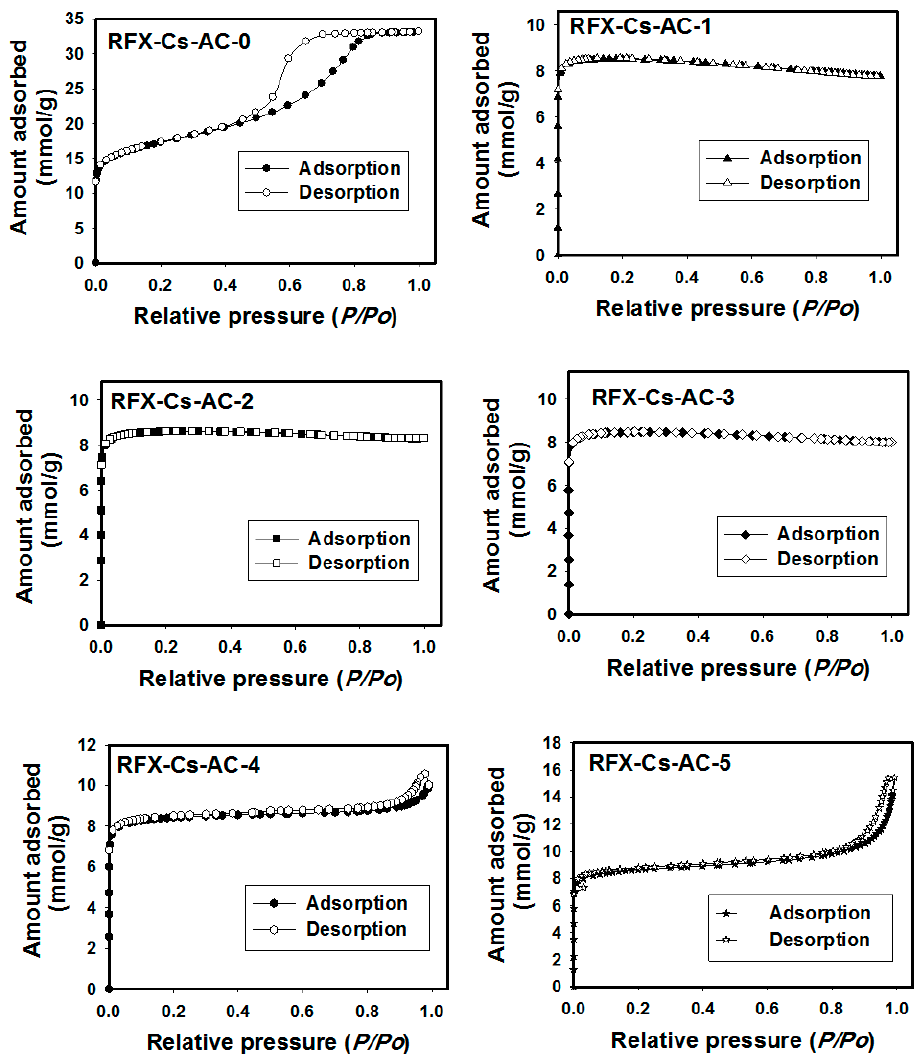
Figure 3. Adsorption/desorption isotherms of N 2 gas at 77 K onto RFX-Cs-AC samples.